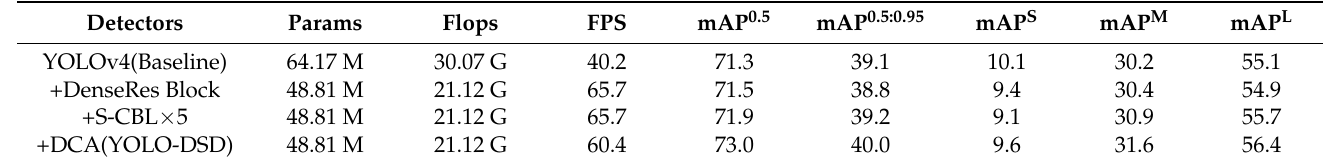
Table 2. The ablation results of YOLO-DSD.